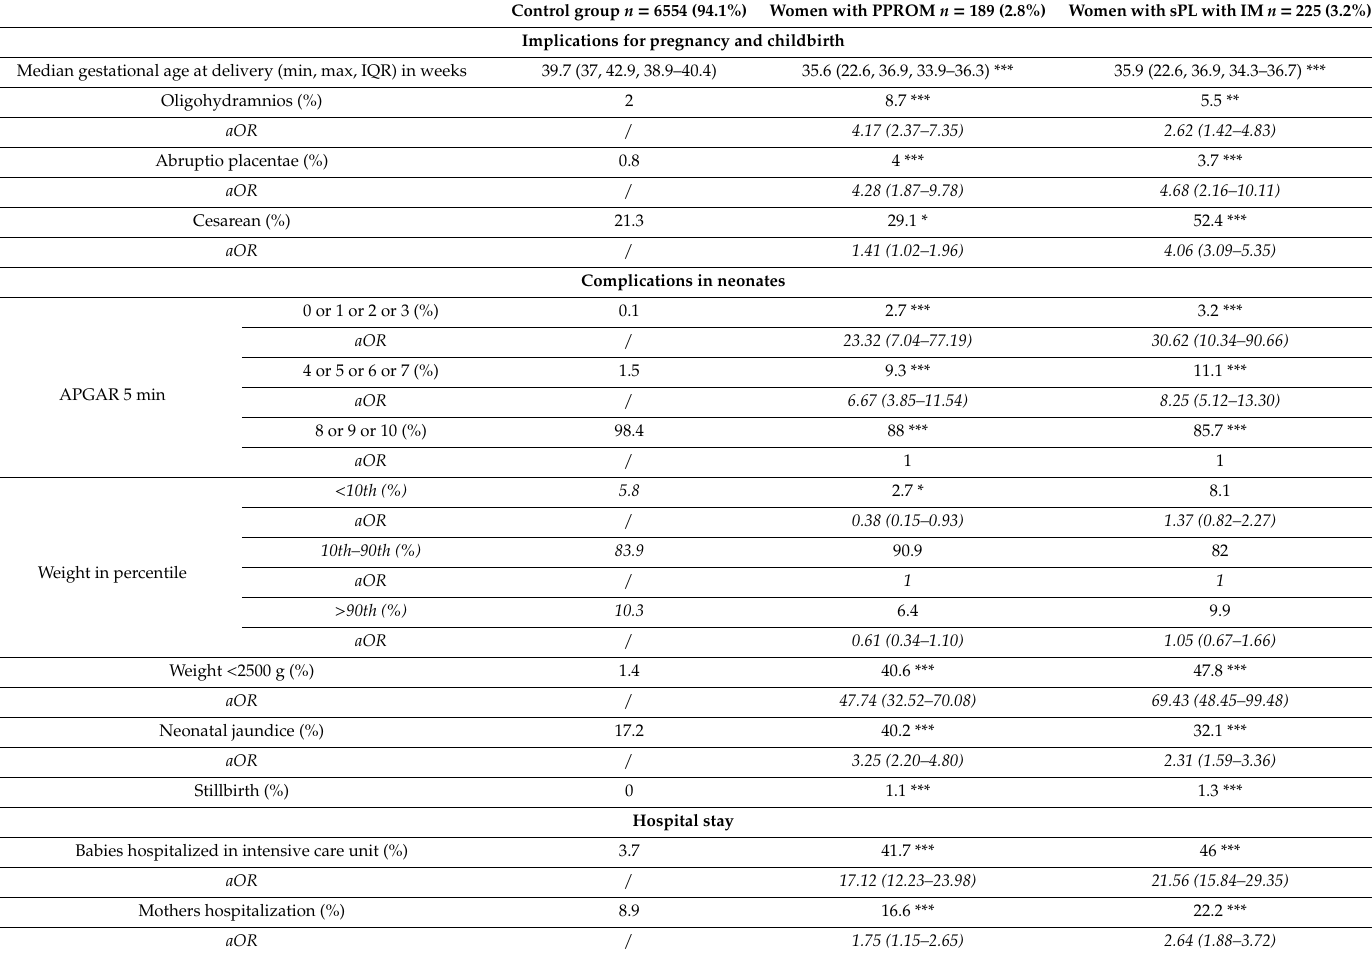
Table 3. Outcomes of preterm premature rupture of